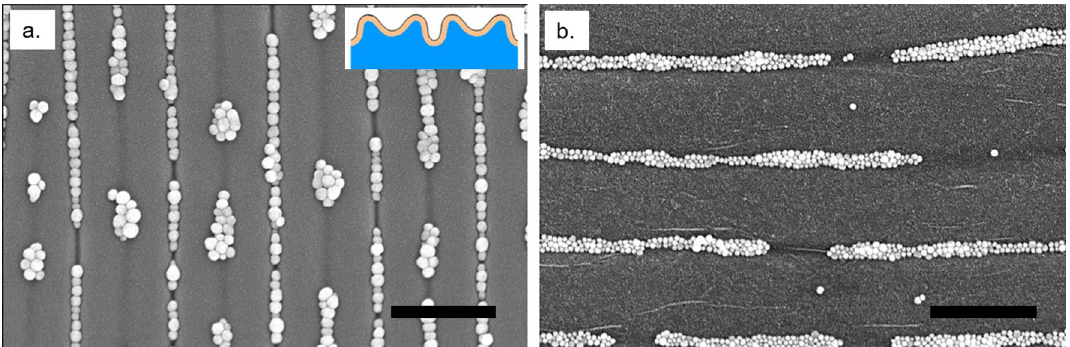
Figure 3. Effects of excessive strain and oversized wrinkles on nanoparticle alignment. Defects in AuNP alignment due to excessive strain causing period doubling (inset: a schematic of period doubled winkles) ( a ). Oversized wrinkles leading to overfilling of NPs ( b ). Scale bars 500 nm.